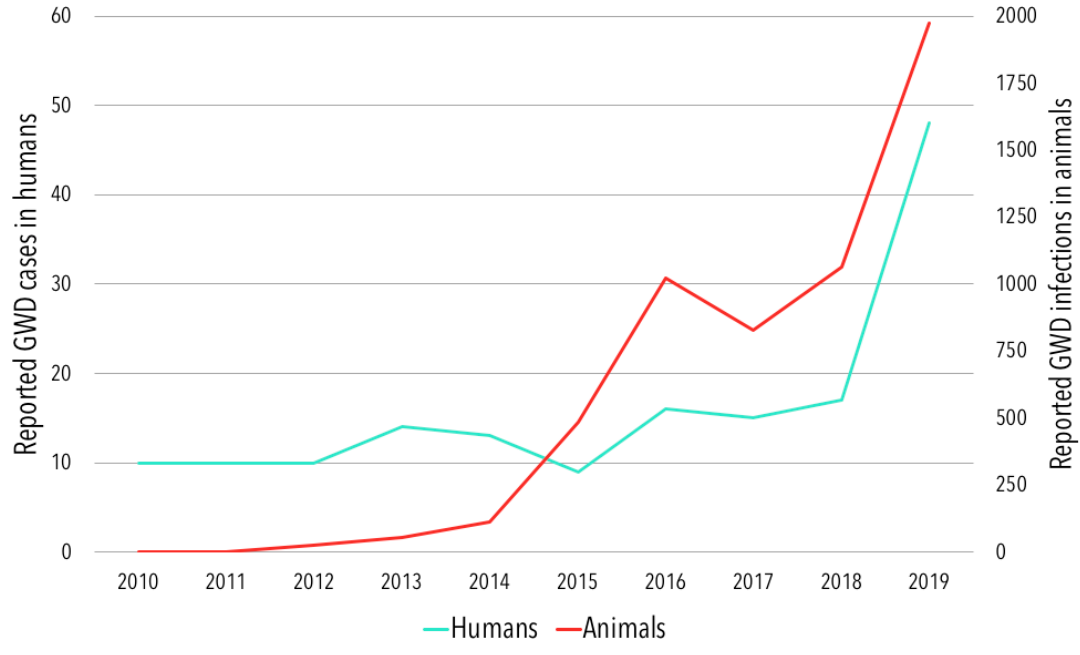
Figure 2. Reported human cases and animal infections of Guinea worm disease in Chad, 2010–2019.